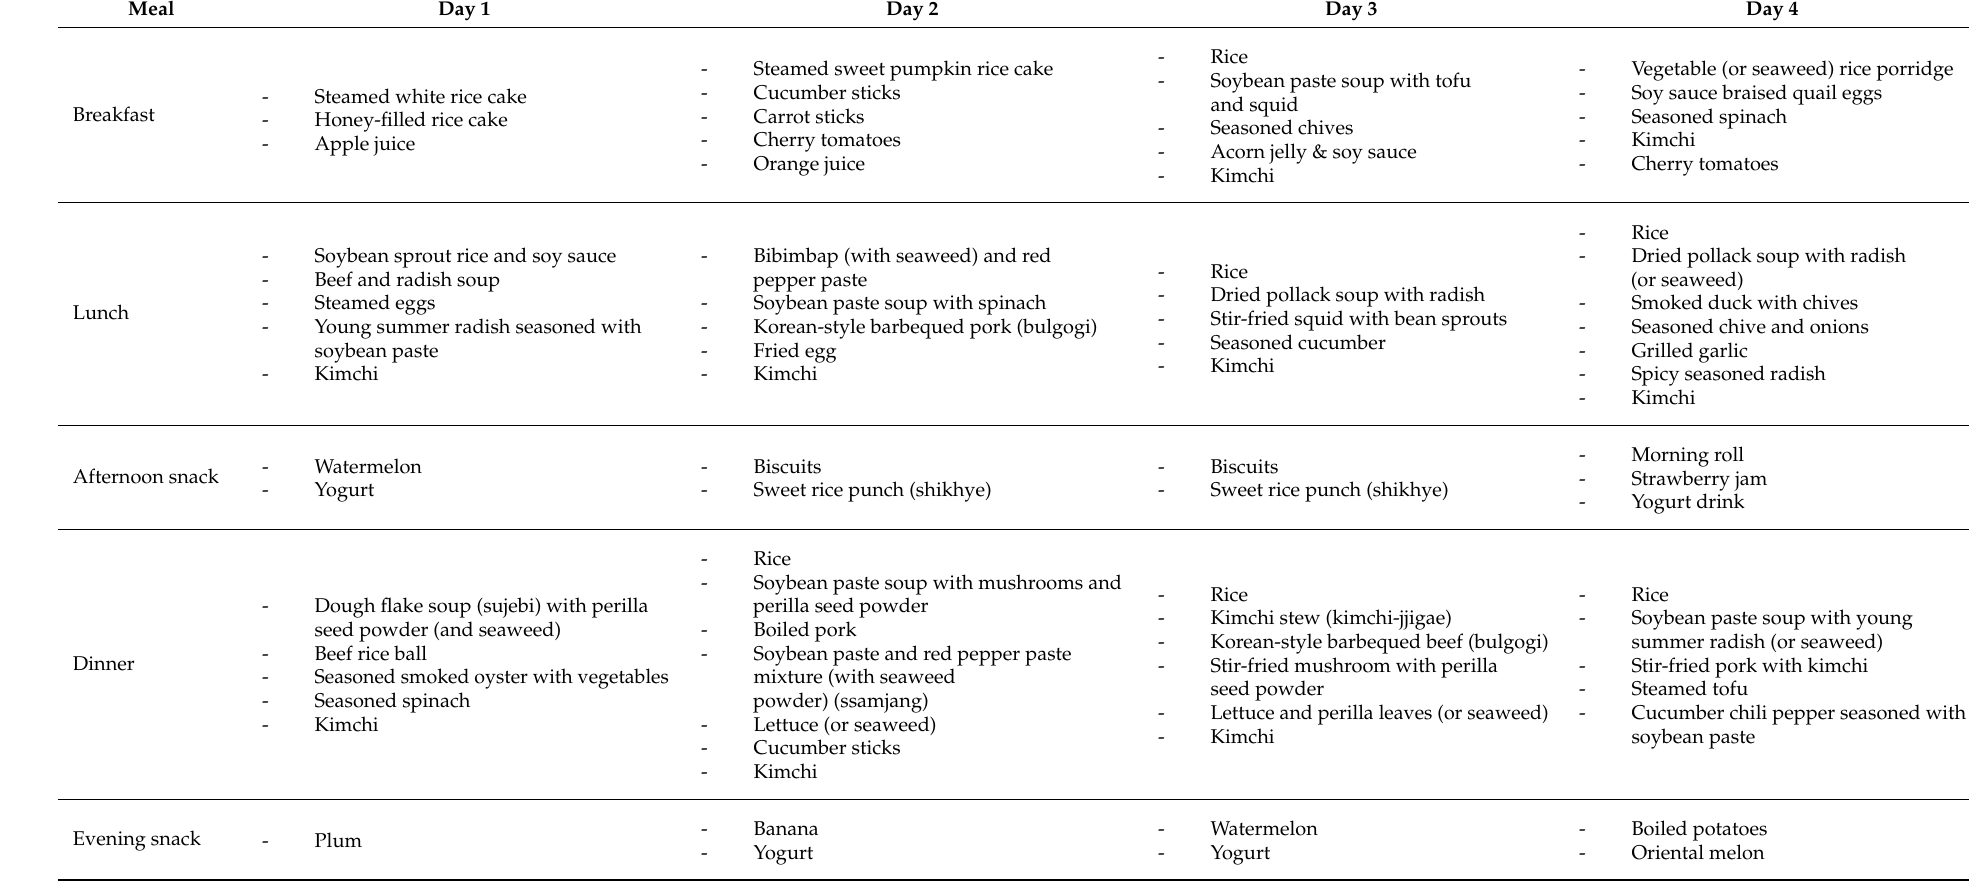
Table 1. The food items served during the